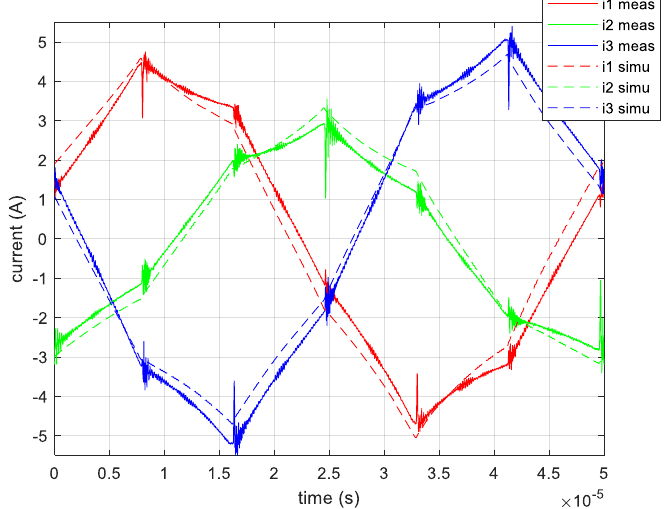
Figure 14. MFT T2 no load test primary current: experimental result (solid line), magnetic transient simulation result (dashed line).